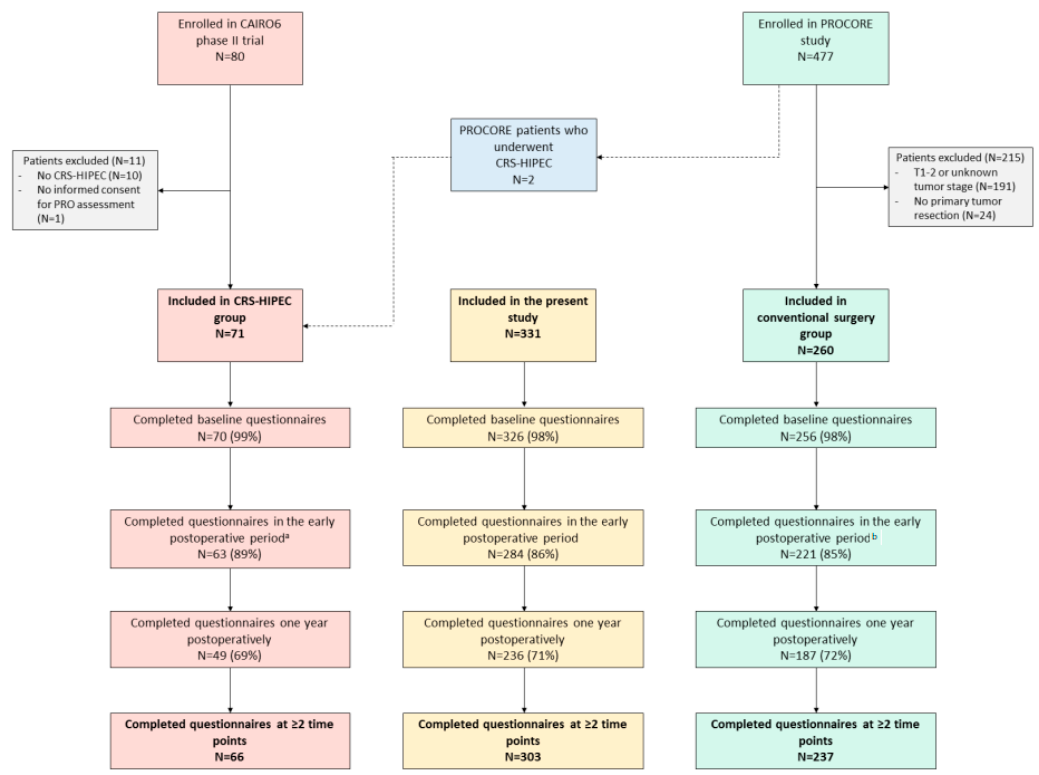
Figure 1. Patient flowchart. CRS-HIPEC cytoreductive surgery and hyperthermic intraperitoneal chemotherapy; a ± 12 weeks postoperatively; b ± 5 weeks postoperatively.